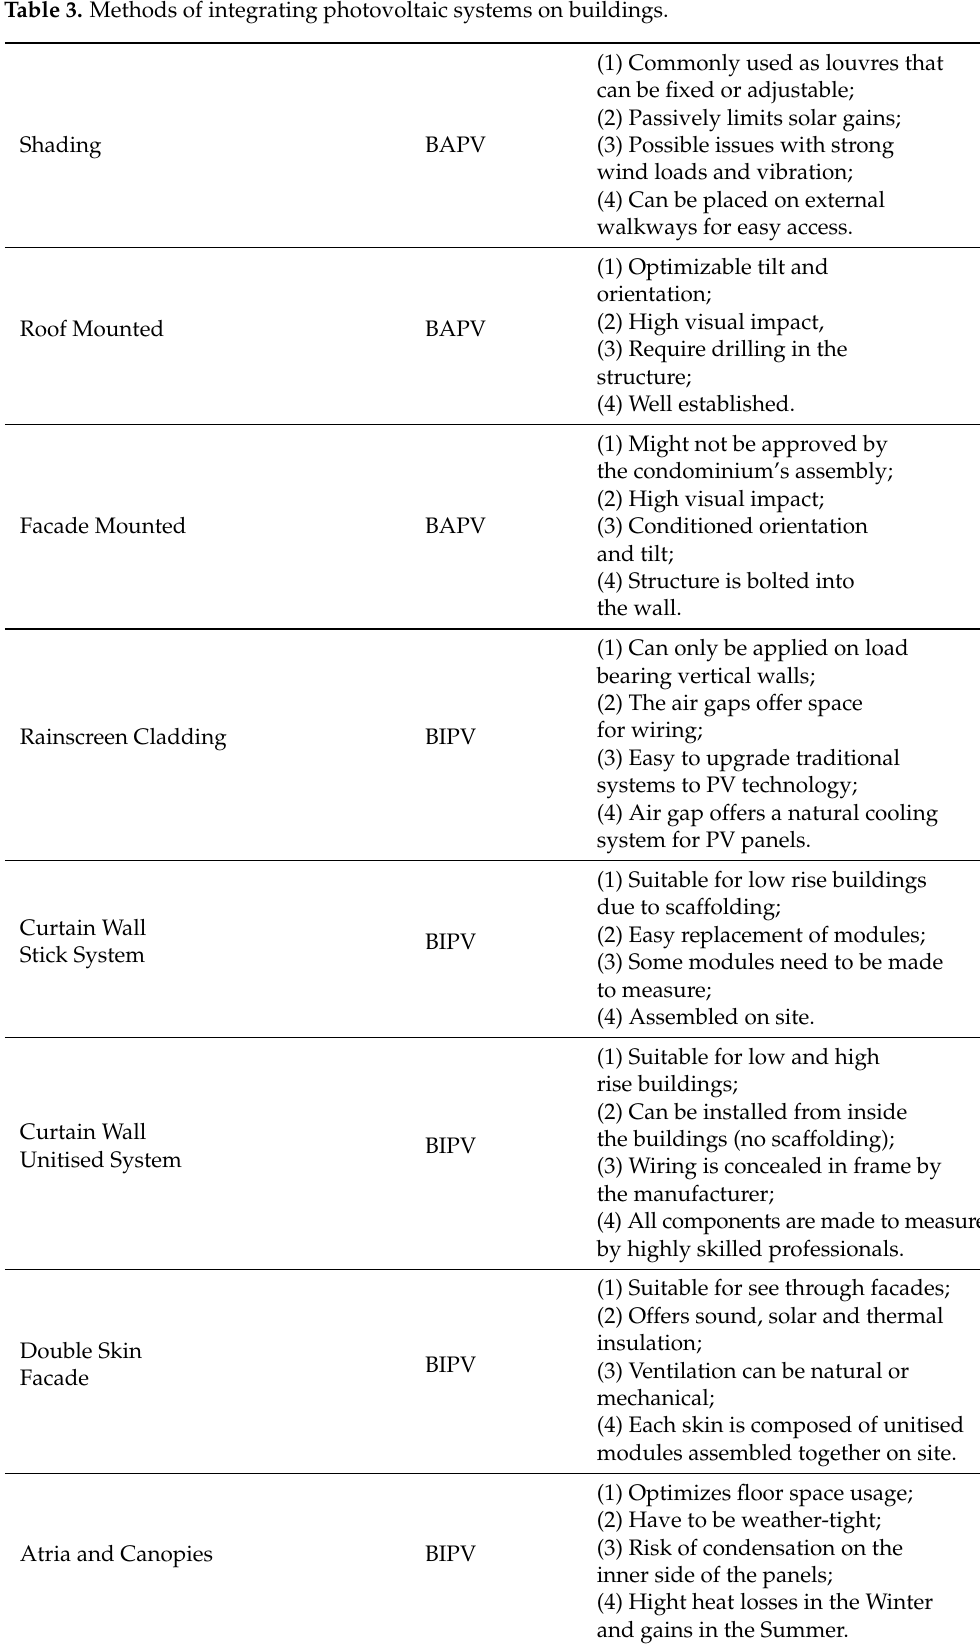
Table 3. Methods of integrating photovoltaic systems on buildings.